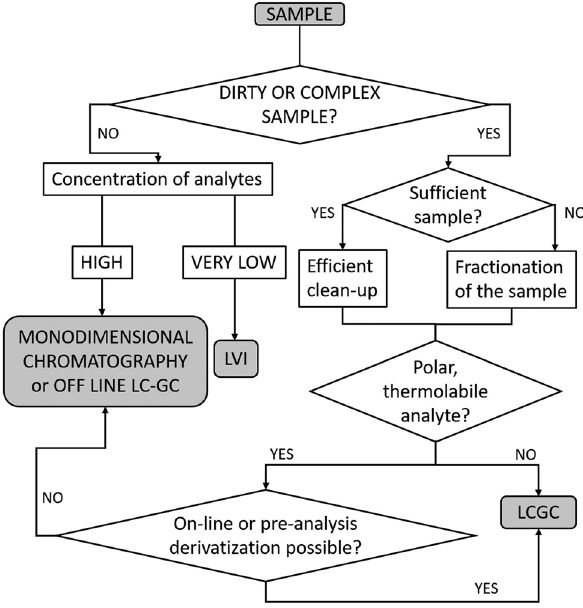
Figure 3: Flowchart to decide when to use LVI or online LC - GC. Modi fi ed from Figure 1 of ref. [ 18 ]